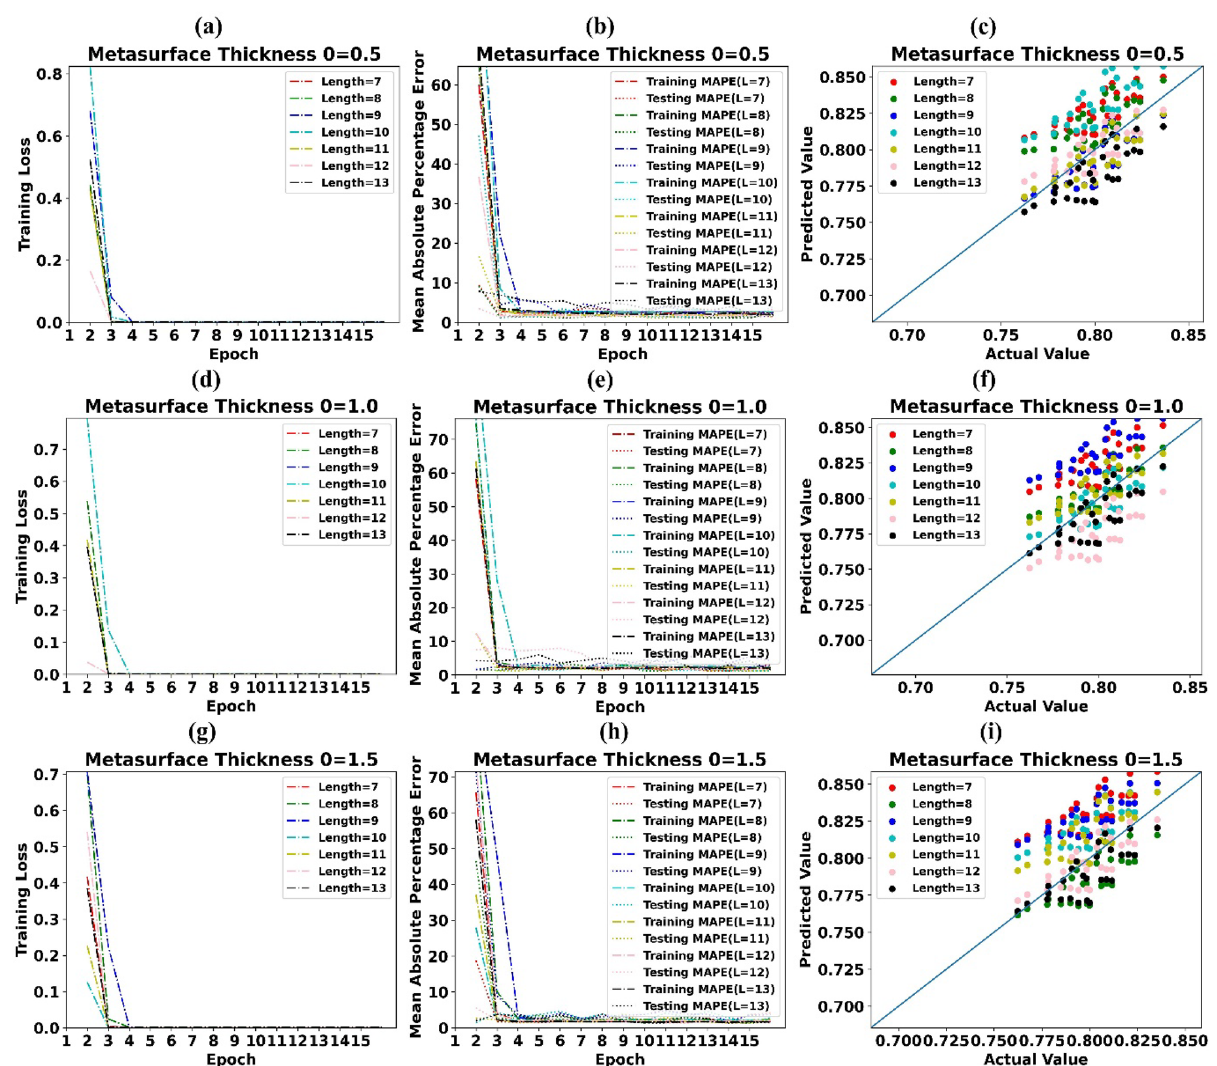
Figure 6. ( a ) Training Loss of LSTM model for Metasurface Thickness 0.5 µm ( b ) MAPE of LSTM model for Metasurface Thickness 0.5 µm ( c ) Predicted values of absorption by LSTM vs simulated values of absorption for Metasurface Thickness 0.5 µm ( d ) Training Loss of LSTM model for Metasurface Thickness 1.0 µm ( e ) MAPE of LSTM model for Metasurface Thickness 1.0 µm ( f ) Predicted values of absorption by LSTM vs simulated values of absorption for Metasurface Thickness 1.0 µm ( g ) Training Loss of LSTM model for Metasurface Thickness 1.5 µm ( h ) MAPE of LSTM model for Metasurface Thickness 1.5 µm ( i ) Predicted values of absorption by LSTM vs simulated values of absorption for Metasurface Thickness 1.5